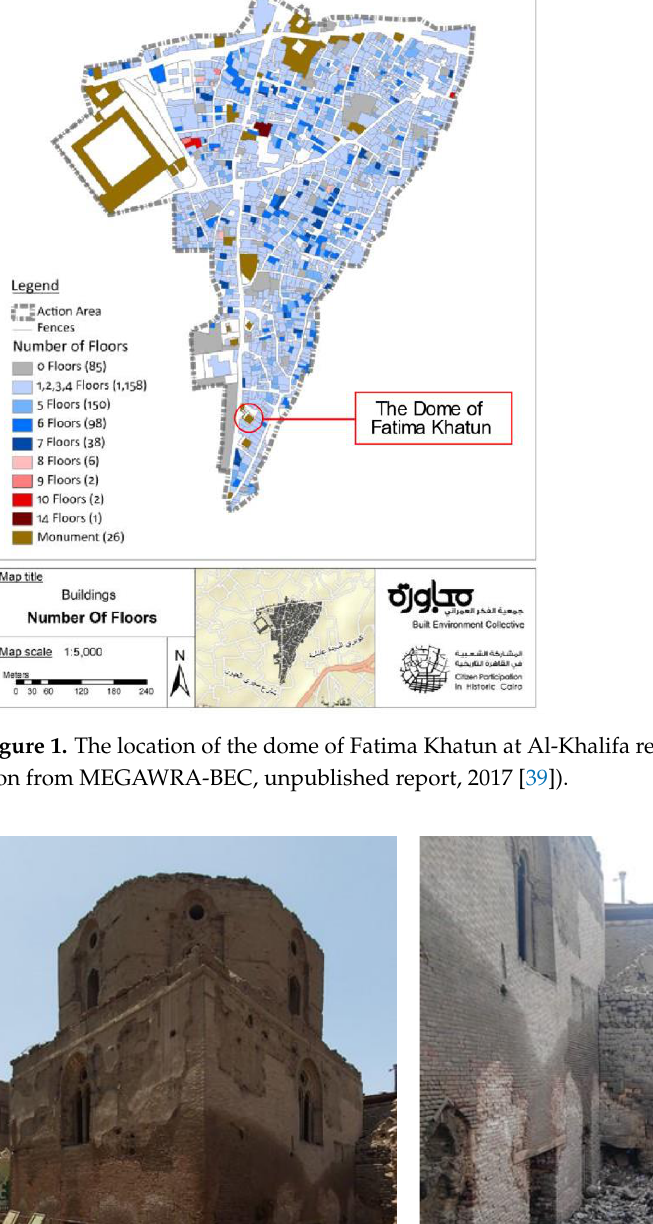
Figure 3. Elevation levels (looking north). Each of the four perpendicular walls has a thickness of about two meters except for two inside recesses in the middle. The first recess has a width of 5.3 m, with a thickness of 0.5 m and a height of 11.3 m, and the second recess has a width of 3.5 m with a thickness of 0.4 m and a height of 10.6 m. Hence, the overall wall thickness is about 1.1 m in the location of the two recesses, as shown in Figure 5. On the other hand, the octagonal walls have a uniform thickness of about 1.1 m. Each of the four perpendicular walls has a thick- ness of about two meters except for two inside recesses in the middle. As shown in Figure 6, the first recess has a width of 5.3 m with a thickness of 0.5 m and a height of 11.3 m, and the second recess has a width of 3.5 m with a thickness of 0.4 m and a height of 10.6 m. Hence, the overall wall thickness is about 1.1 m in the location of the two recesses. On the other hand, the octagon walls have a uniform thickness of about 1.1 m.